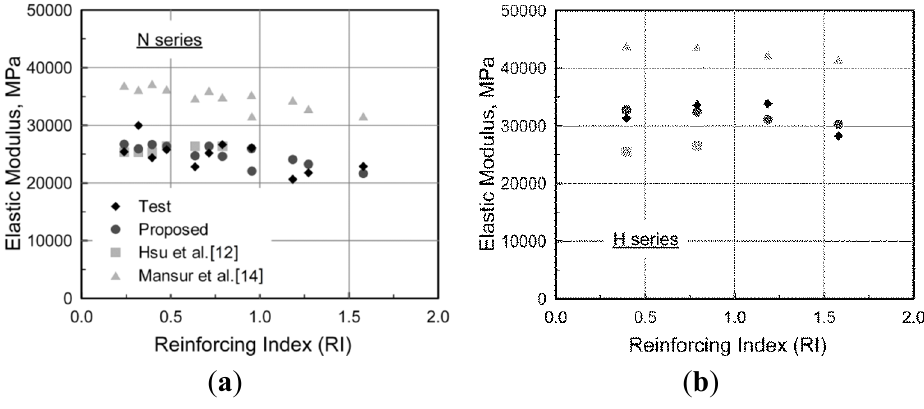
Figure 8. Comparison of the elastic modulus. ( a ) N Series; ( b ) H